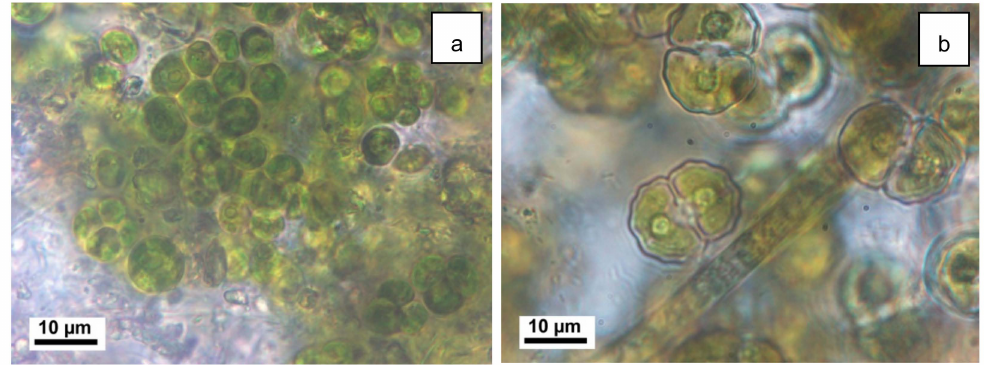
Figure 6. Photographs of samples taken using optical microscopy: ( a ) Chlorosarcinopsis sp. cells can be seen on the left; ( b ) Cosmarium sp. cells can be seen on the right, along with a filament of